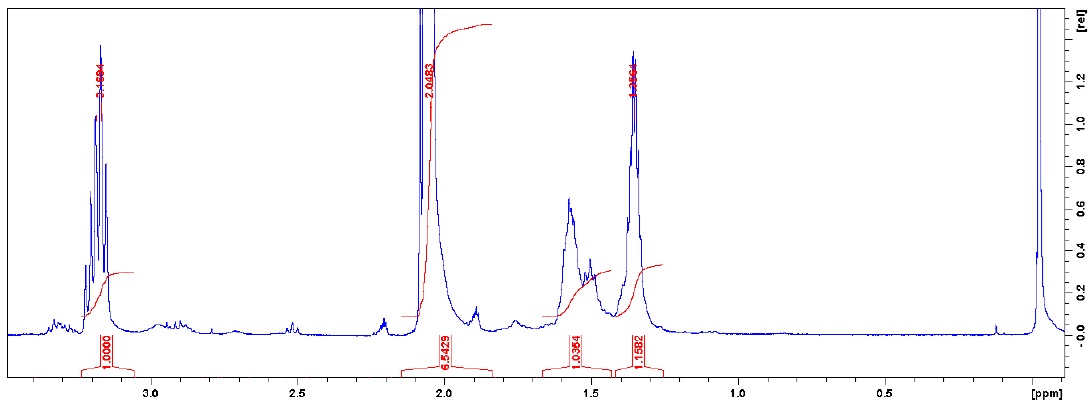
Figure 3. NMR spectrum of polymer -isomer a- (dissolved in CD 3 COCD 3